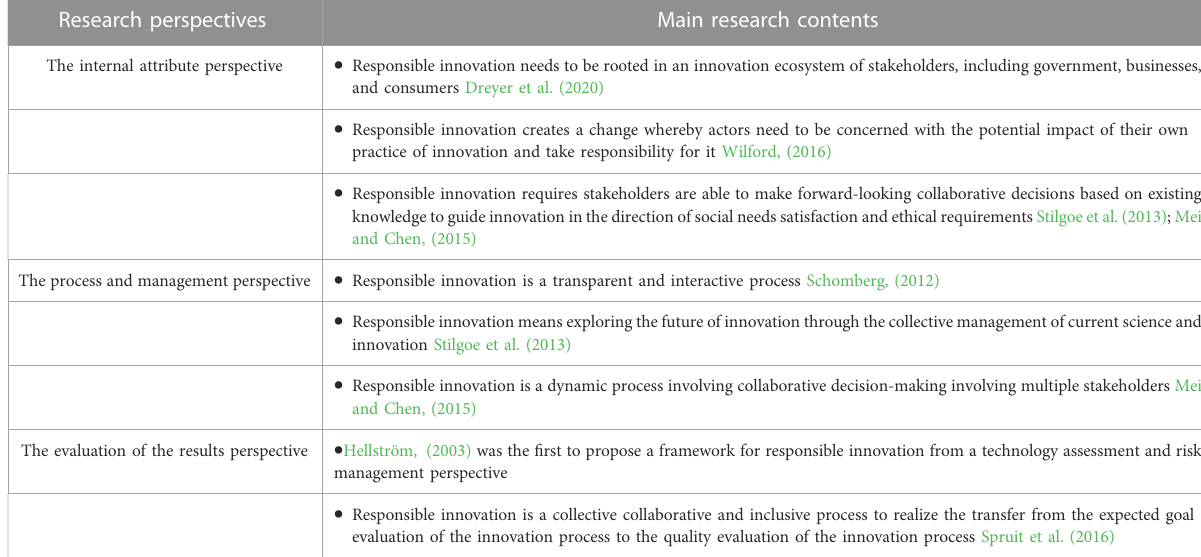
TABLE 1 The research on concept of responsible innovation. Research